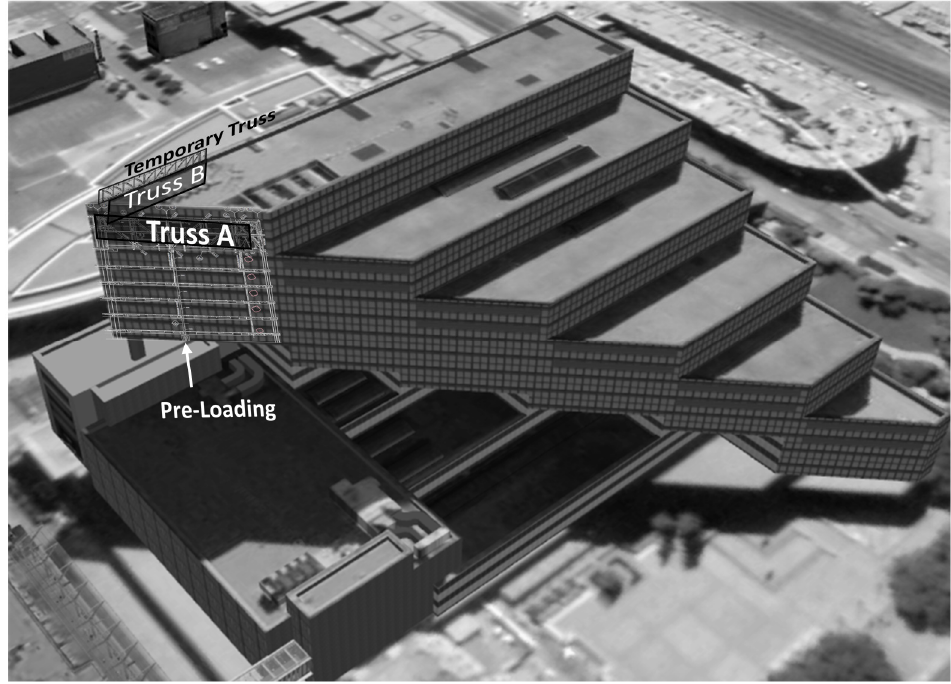
Figure 1. The approximate position of Truss A, Truss B, pre-loading jack, and temporary Truss. Courtesy of Google© Earth.